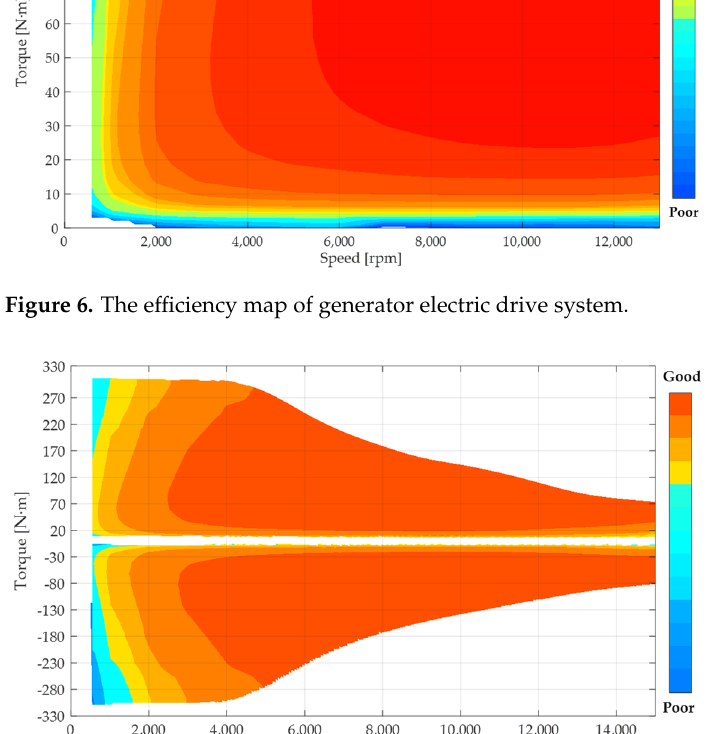
Figure 7. The efficiency map of motor electric drive system.